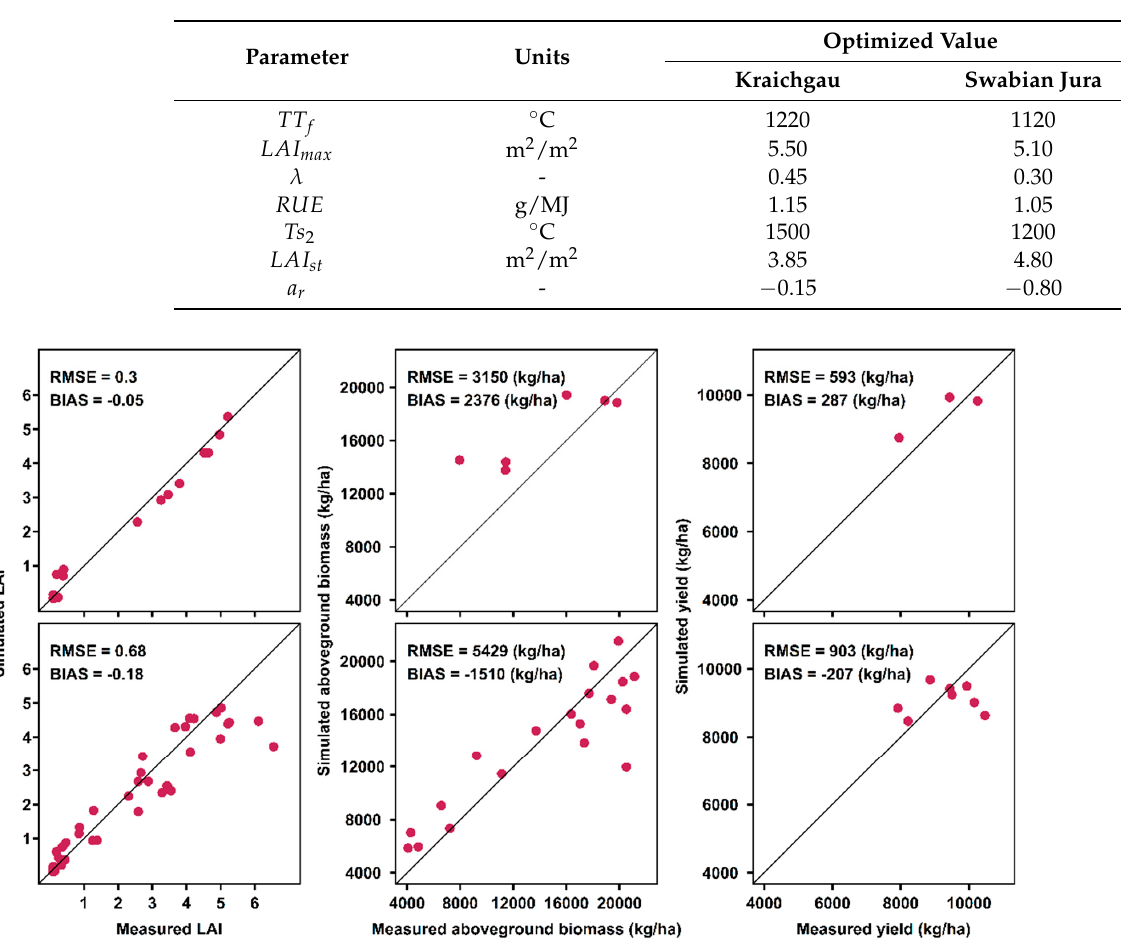
Figure A1. Calibration ( upper three panels ) and evaluation ( lower three panels ) results of the PILOTE model in Kraichgau (KR).